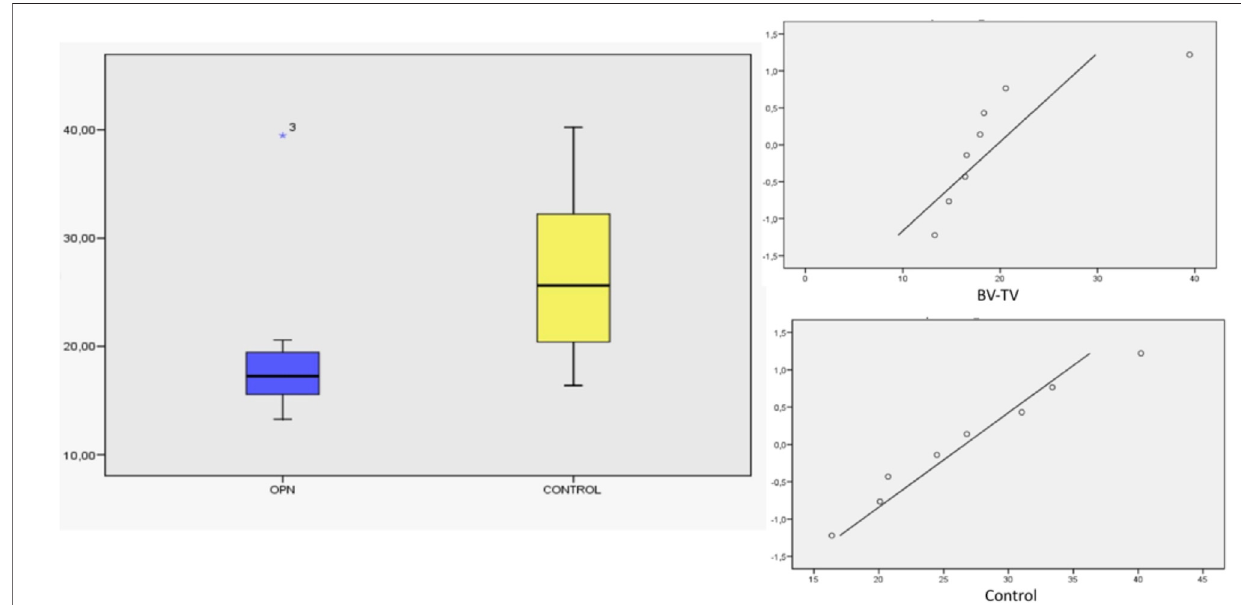
FIGURE 4 | Boxplot and Q-Q plot for BV-TV.